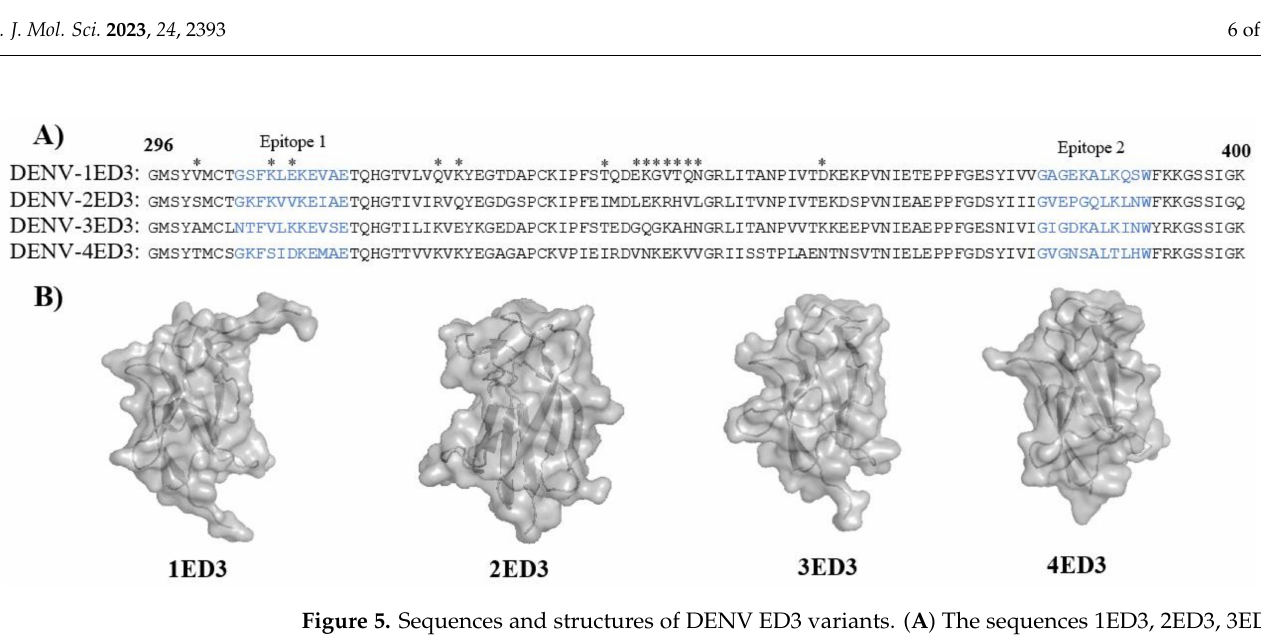
Figure 5. Sequences and structures of DENV ED3 variants. ( A ) The sequences 1ED3, 2ED3, 3ED3, and 4ED3 were retrieved from the UniProt IDs P17763, P14340, P27915.1, and P09866, respectively. The sequences were aligned using the online tool CLUSTAL W “www.ebi.ac.uk/Tools/msa/clustalo (accessed on 13 February 2022)” using the default settings [23]. The amino acid residues comprising epitope 1 and epitope 2 are marked in blue color. * The amino acid residues differ among the four different ED3s. ( B ) The surface structures models of 1ED3, 2ED3, 3ED3, and 4ED3 were generated from PBD IDs 3G7T.pdb [24], 4UTC.pdb [25], 3VTT.pdb [26], and 3WE1.pdb [27], respectively,